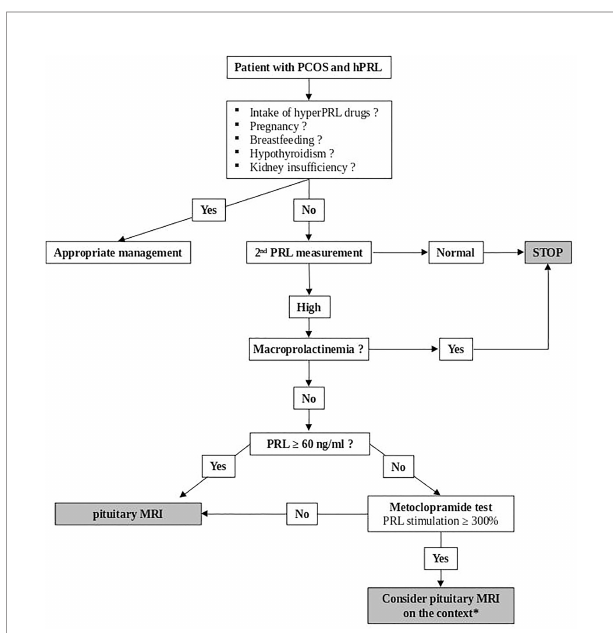
FIGURE 5 | Decisional algorithm for the etiology of hPRL in PCOS women. *Pituitary MRI is advised in case of pituitary tumoral syndrome, dopamine agonist intention-to-treat or abnormalities of other pituitary